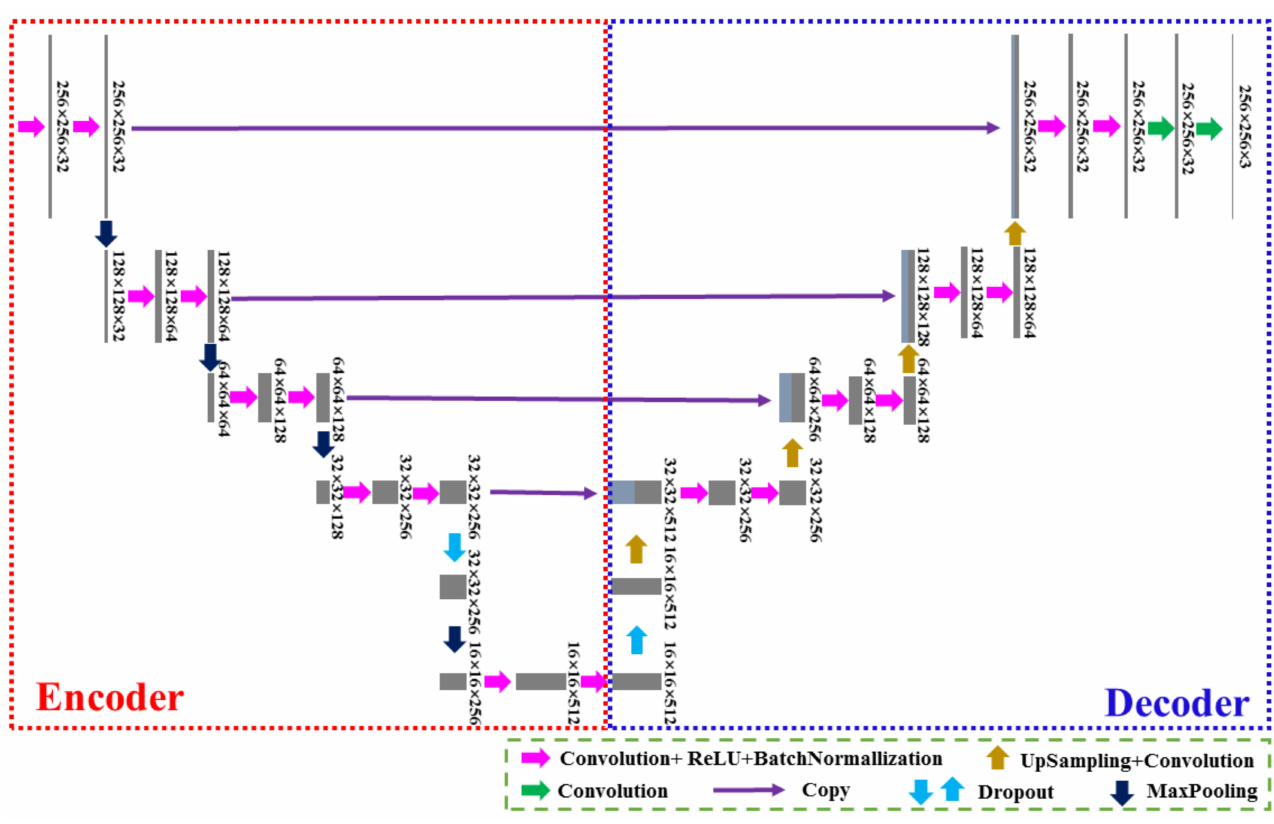
Figure 12. U-Net